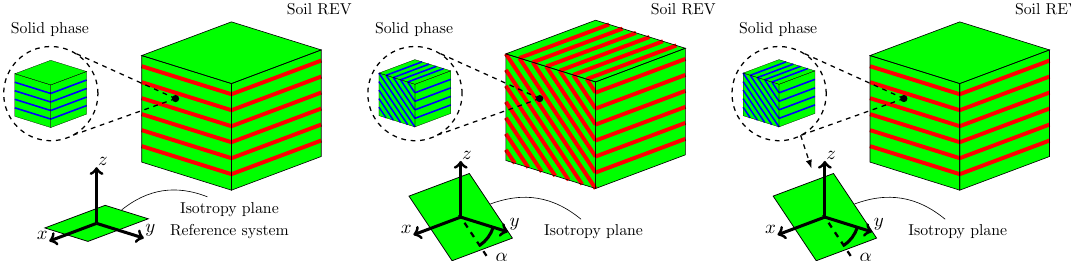
( c ) Isotropy plane of porous material non-coaxial with the isotropy plane of solid phase.